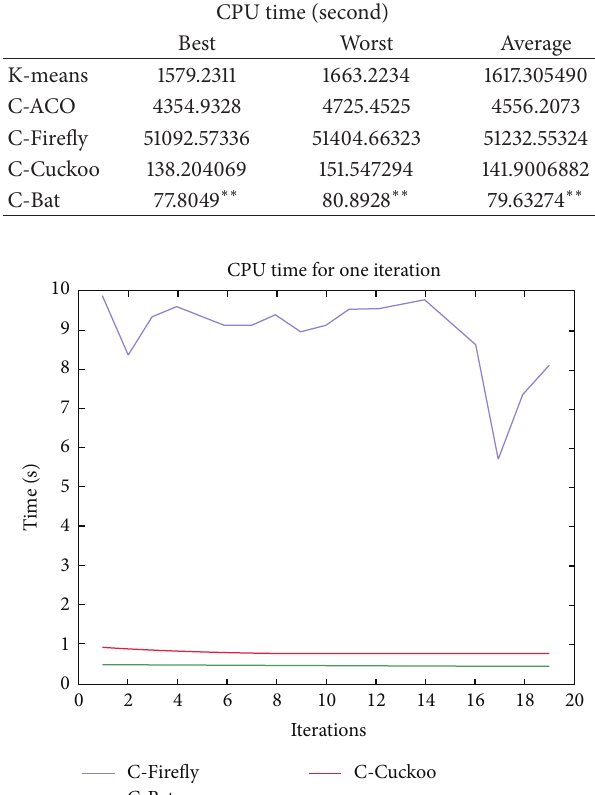
Table10:TestingobjectivefunctionfitnessandCPUtimeconsump- tion on Haberman.